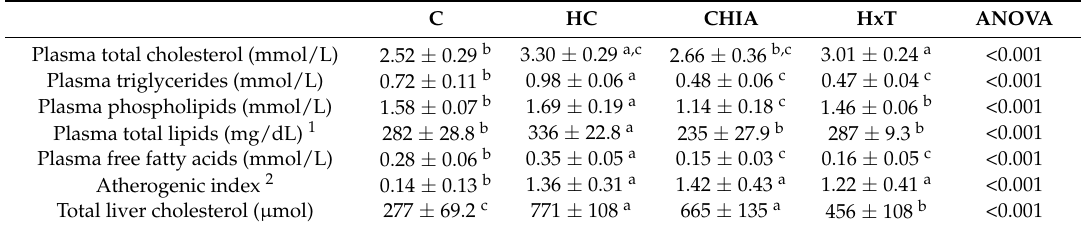
Table 3. Plasma and liver lipid composition and atherogenic